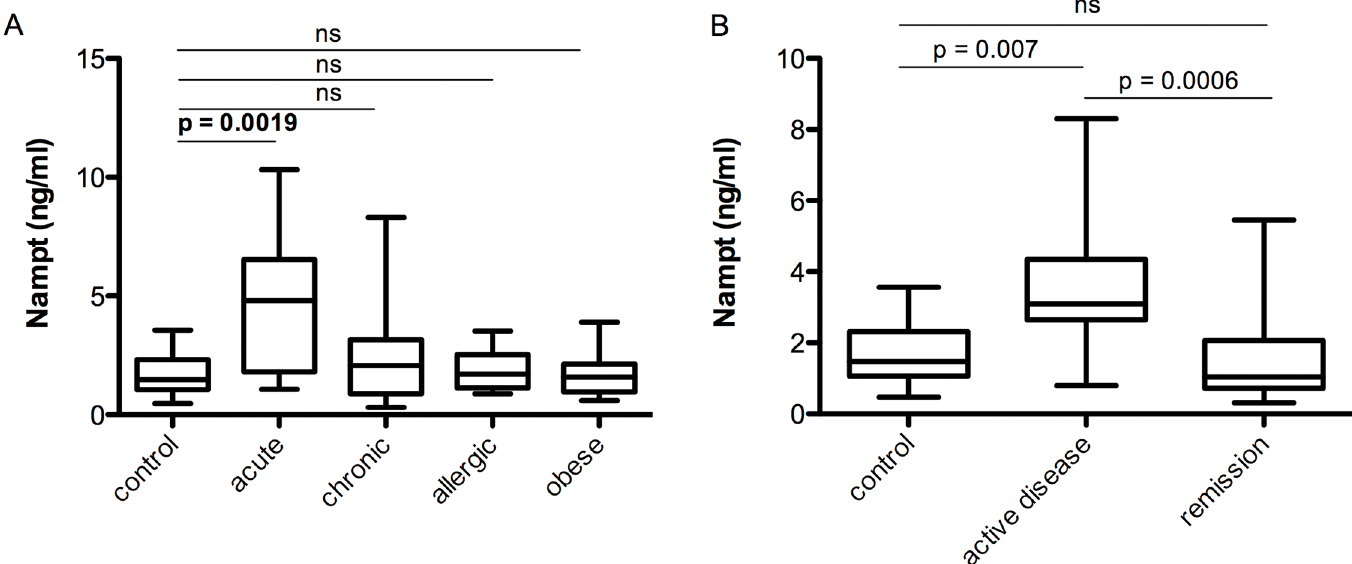
Fig 1. NAMPT serum concentrations in distinct inflammatory conditions. Comparison of NAMPT concentrations betweenpatient groups of distinct inflammatory conditions and controls (A). Patients with chronicinflammation were further stratified into patients with active disease vs. patients without symptoms (remission) (B). Boxes are interquartile range, whiskersare minimum to maximum. Statistical significancewas assessedby ANOVA and Tukey HSD test in log transformed values.